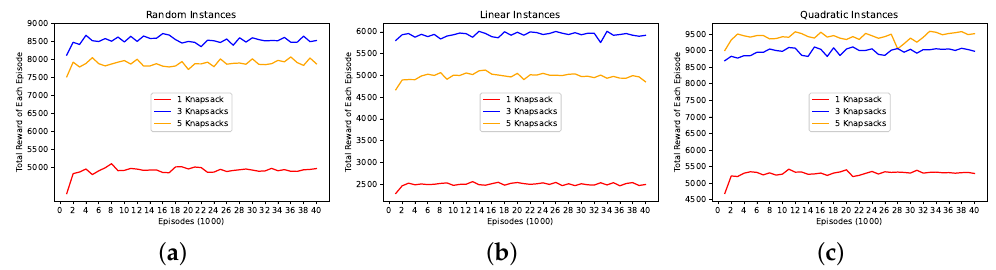
Figure 3. DRL training information of reward in episodes. ( a ) Reward of RI; ( b ) Reward of LI; ( c ) Reward of QI.